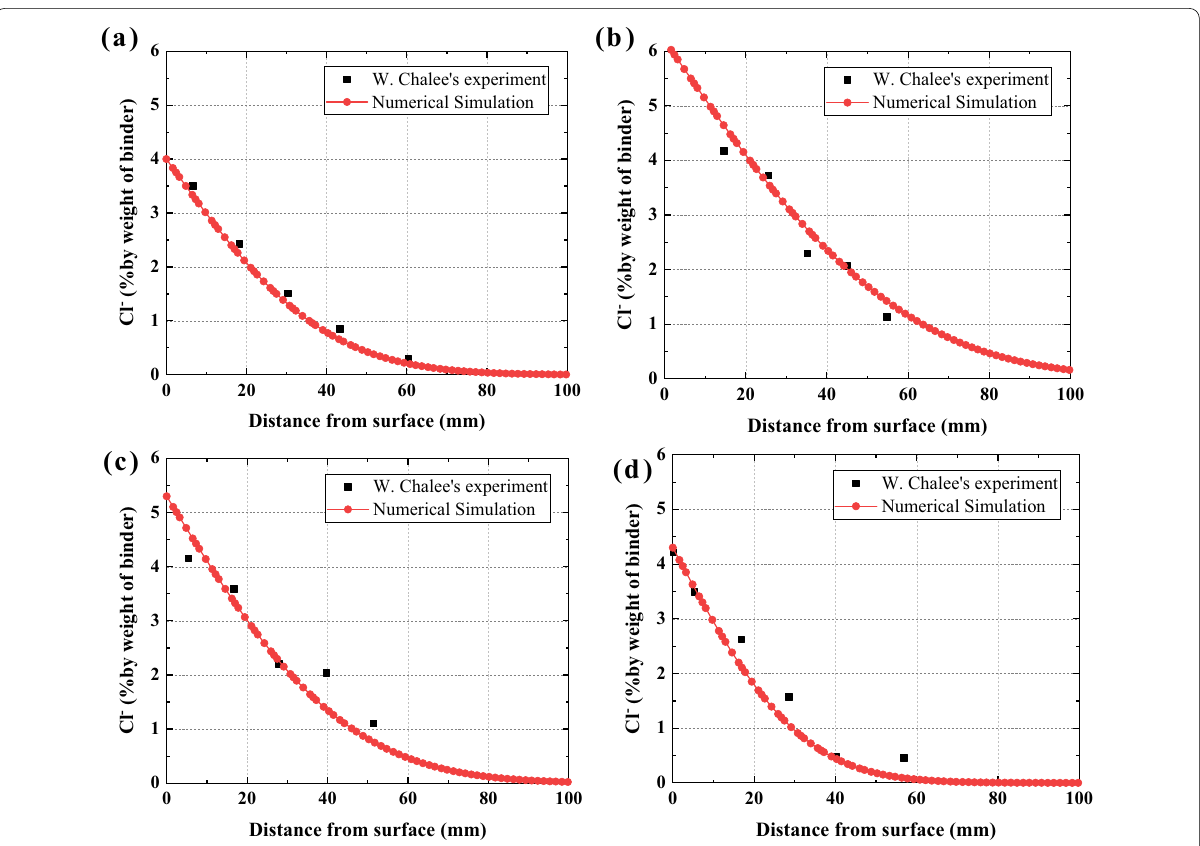
Fig. 4 Chloride diffusion verification: a w / c time 5 years. =